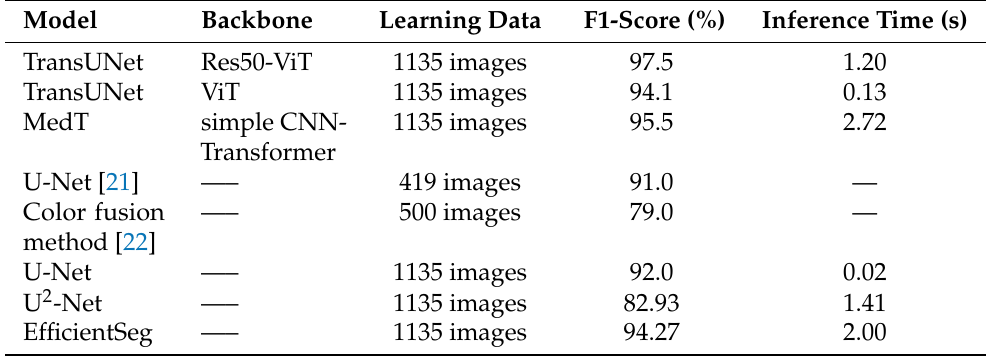
Table 3. Comparative analysis of TransUNet, MedT, U-Net, Color fusion method, U 2 -Net and EfficientSeg using CorsicanFire dataset with image size of